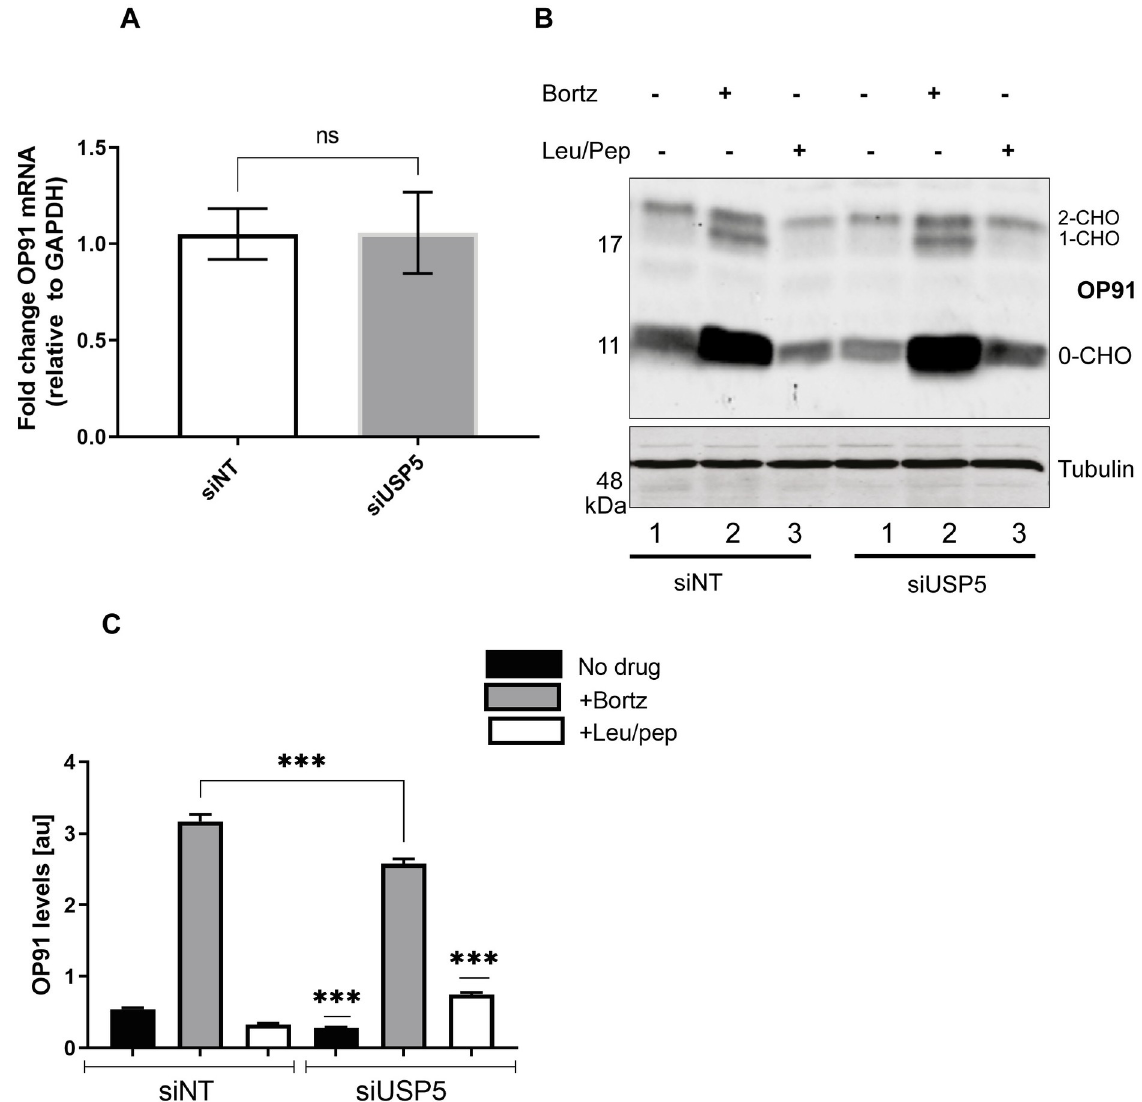
Fig 4. USP5 protects OP91 against proteasomal degradation. A) HeLa T-REx Flp-In cells stably expressing OP91 were seeded at 50% confluence followed by transfection of oligos for knockdown of USP5 or a non-targeting oligo. Cells were grown for 48 hrs followed by induction of OP91 expression and growth for a further 20 hrs post. Cells were harvested and total RNA extracted and used in a qPCR reaction following standard qPCR protocol. B) Cells grown as described in A, inhibitors of the proteasome and autophagy were added 24 hours before cells were harvested. Samples were analysed by SDS-PAGE and Western blotting for OP91 and Tubulin loading control. C) OP91 signals were quantified using Odyssey 1 Fc Imaging System and normalised to the tubulin loading control, values show standard errors for n = 3. Pairwise comparisons were performed using GraphPad Prism. Student t-test: P > 0.05 = ns, P � 0.05 = � , P � 0.01 = �� , P � 0.001 = ��� and P � 0.0001 = ����